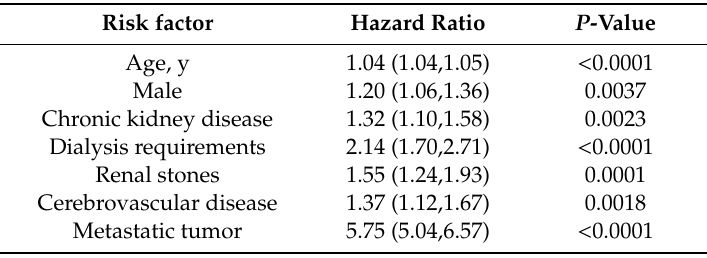
Table 2. Cox model-based analysis of significant prognostic factors, including age, gender, and comorbidities of kidney cancer